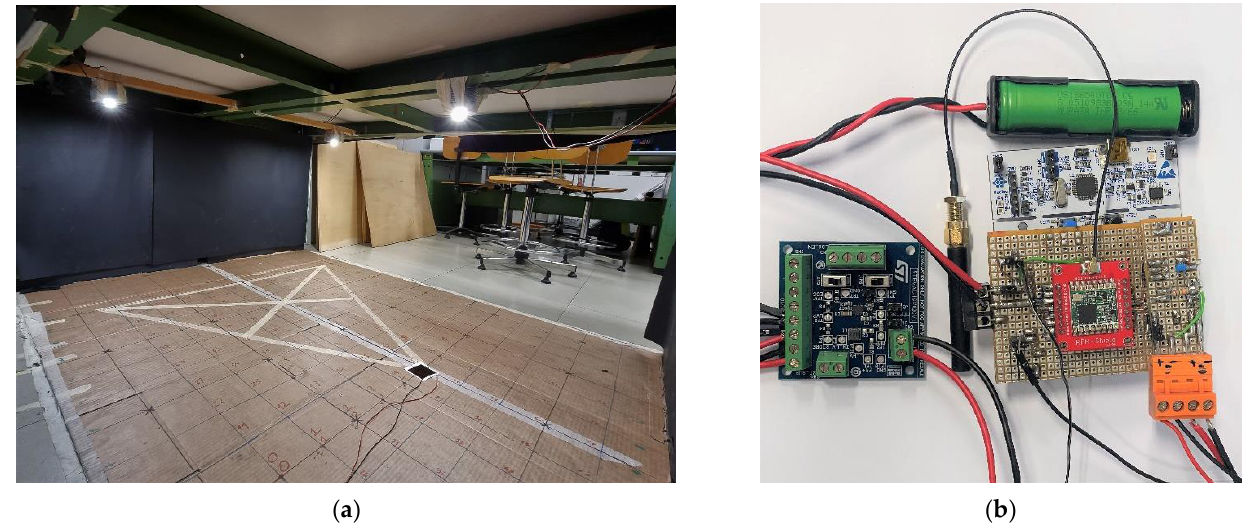
Figure 2. ( a ) The measurement area with the three LEDs and the localization grid at 10 cm, the LED 1 is the one furthest to the right in correspondence of the PV module. ( b ) The proposed IPS in charge of demodulating the signal, extracting the 2D position and transmitting it via LoRaWAN protocol; the battery management board is on the left.